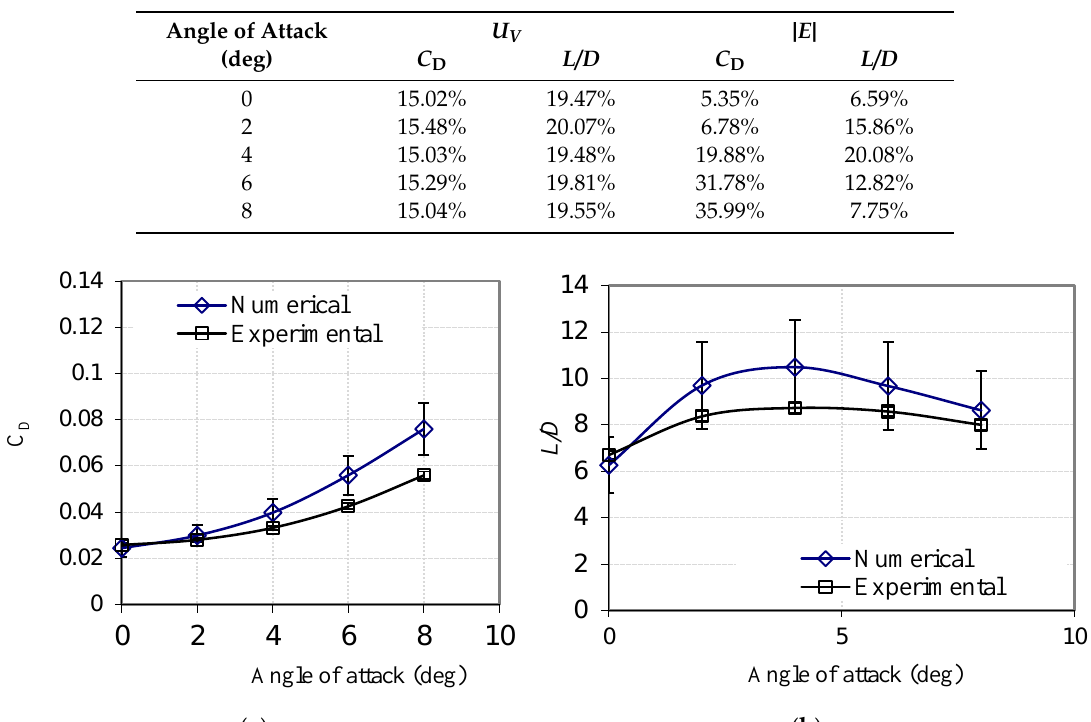
Table 2. Validation Uncertainty and Comparison Error for Drag coe ffi cient and Lift-to-drag ratio for the compound wing at a velocity of 25.5 m / s and ground clearance of 0.15.